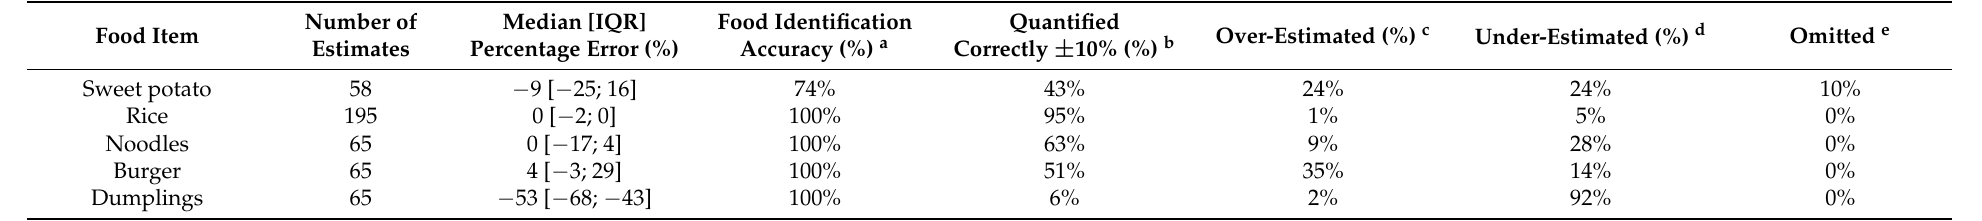
Table 3. Students’ overall digital food viewing skills using a combination of two-dimensional (2-D) and interactive 3-D food models in the second semester ( n =